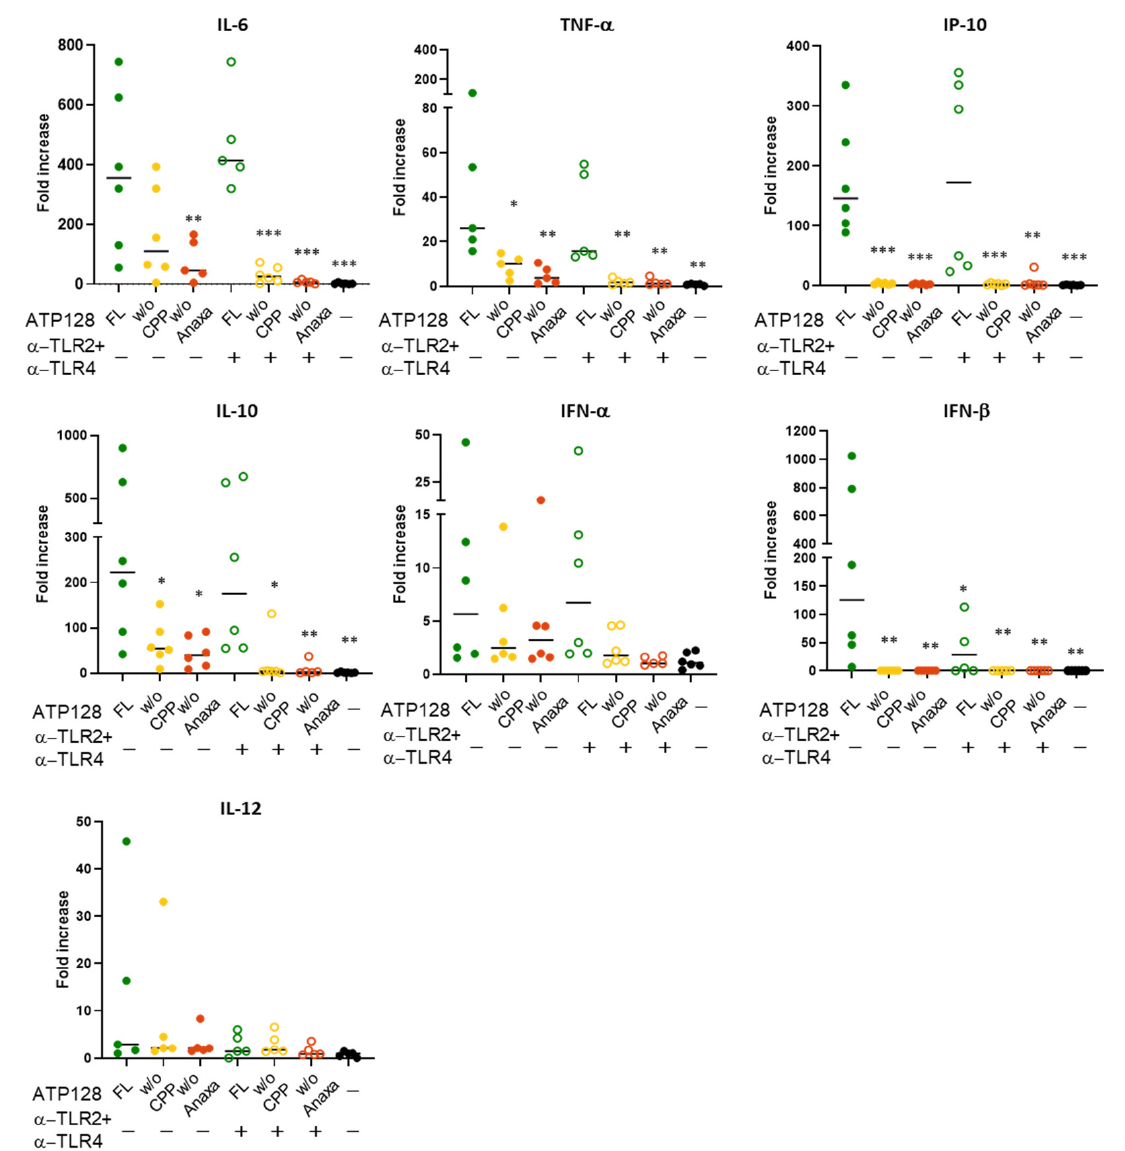
Figure 8. The absence of the CPP and Anaxa domain greatly affects the secretion of pro-inflammatory cytokines and type I IFN. Human moDC were treated with a combination of anti-TLR2 and anti-TLR4 and incubated for 6 h with 300 nM ATP128 FL, w / o CPP, or w / o Anaxa. Cell supernatants were collected to assess the signature of cytokines secretion upon ATP128 stimulation through a multiplex cytokine assay. The values in the graphs represent the fold increase of the stimulated samples to the medium. Each shape is representative of a different buffy coat. Represented are the cytokines that are mainly induced upon stimulation. Values were compared via one-way ANOVA test to the sample stimulated with ATP128 FL. *** p -value < 0.001, ** p -value < 0.01, * p -value < 0.05.